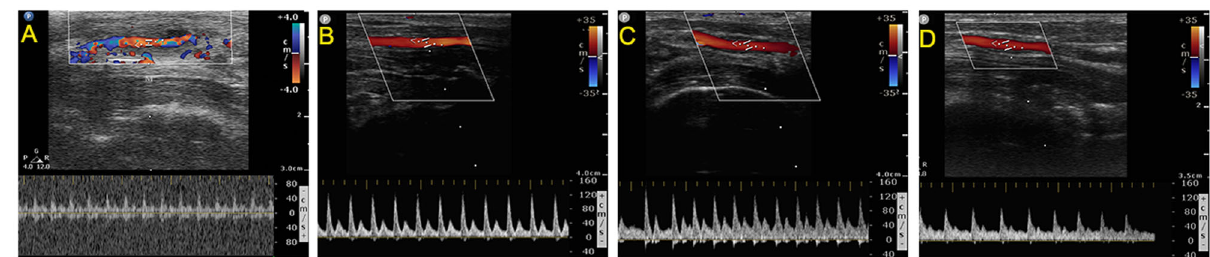
Fig. 9 Circumferential histological images of biotube group stained with haematoxylin and eosin ( A ), Masson's trichrome ( B ), Elastica van Giessen ( C ) after 4 weeks of implantation (Partial enlarged area was